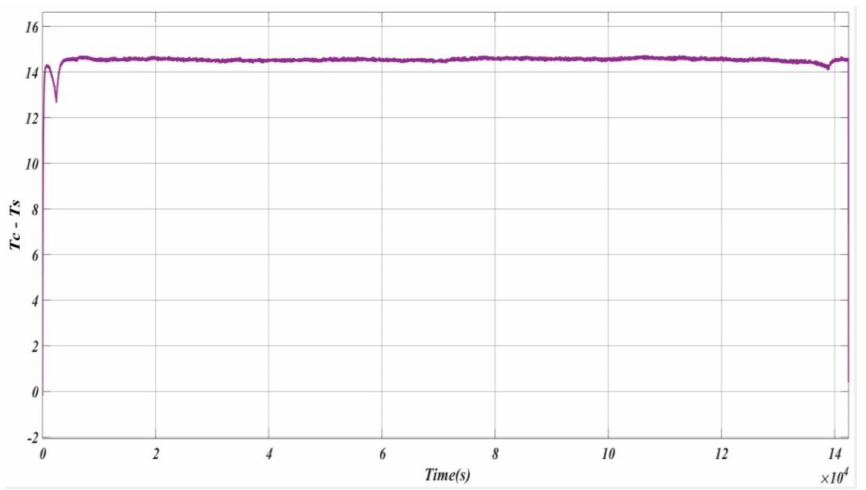
Figure 19. Difference between T c and T s obtained from the first-order thermal